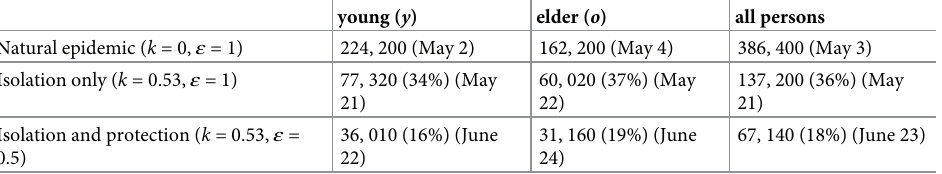
young ( y ) elder ( o ) all persons 60, 020 (37%) (May 137, 200 (36%) (May 21) 22) 21) 36, 010 (16%) (June 31, 160 (19%) (June 67, 140 (18%) (June 23) 22) 24)